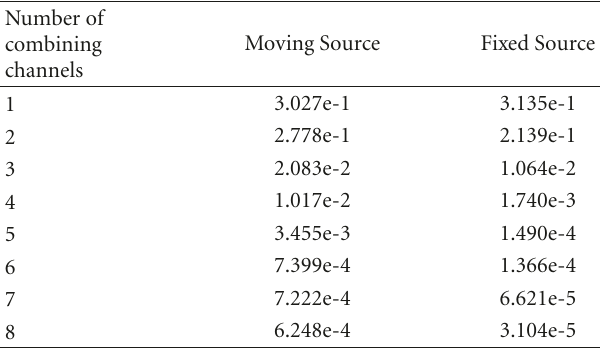
Table 6: Average uncoded BER for Unet06 Experiment. Number